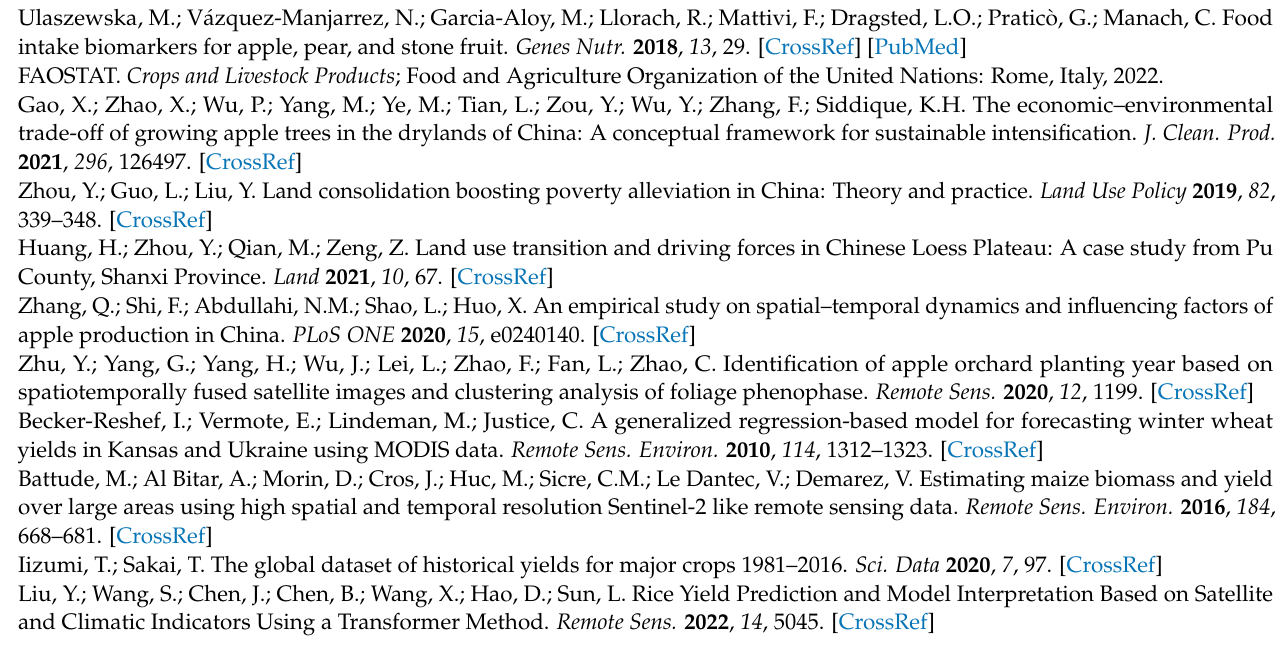
image; Figure S2: The spectral information of pure endmembers for each of the three sensors; Figure S3: The average annual growth rate of different age groups; Table S1: 2018–2019 Statistical Yearbook Data; Table S2: Orchard planting suitability evaluation system; Table S3: BP neural network input data of